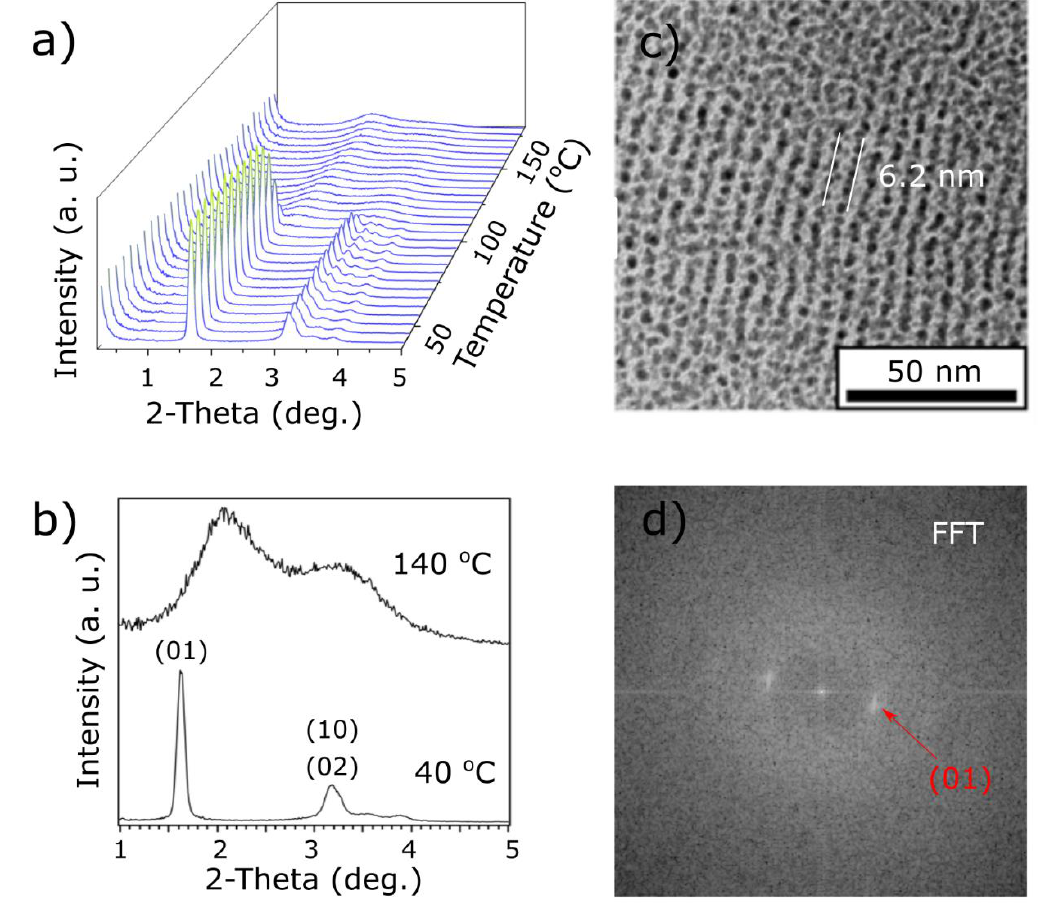
Figure 2. Small-angle X-ray diffraction (SAXRD) and TEM analysis of 2-L A material. ( a ) Temperature evolution of 1D SAXRD profile during heating. ( b ) Comparison of 1D XRD diffractograms collected at 40 and 140 °C. ( c ) TEM image of a heat annealed material. ( d ) 2D Fast Fourier Transformation (FFT) of image shown in (c) with maximum assigned to (01) (red arrow).